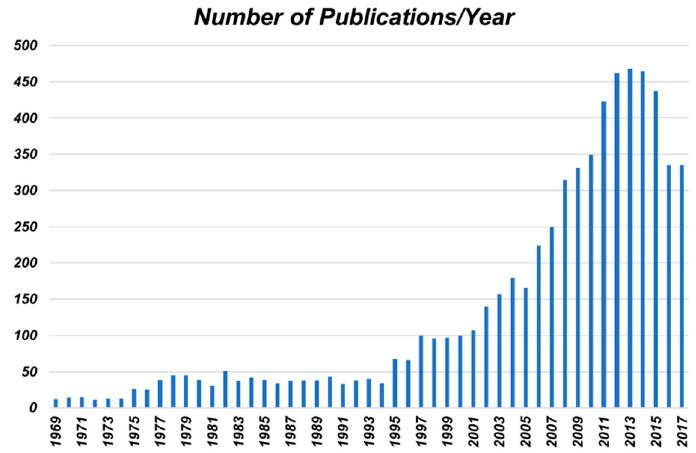
Figure 1. Graph representing the number of peer-reviewed journal articles (found in SciFinder) describing flame resistant (FR) polymers per year between 1969 and 2017.